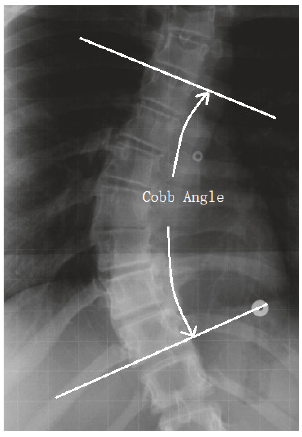
Figure 1: Cobb angle